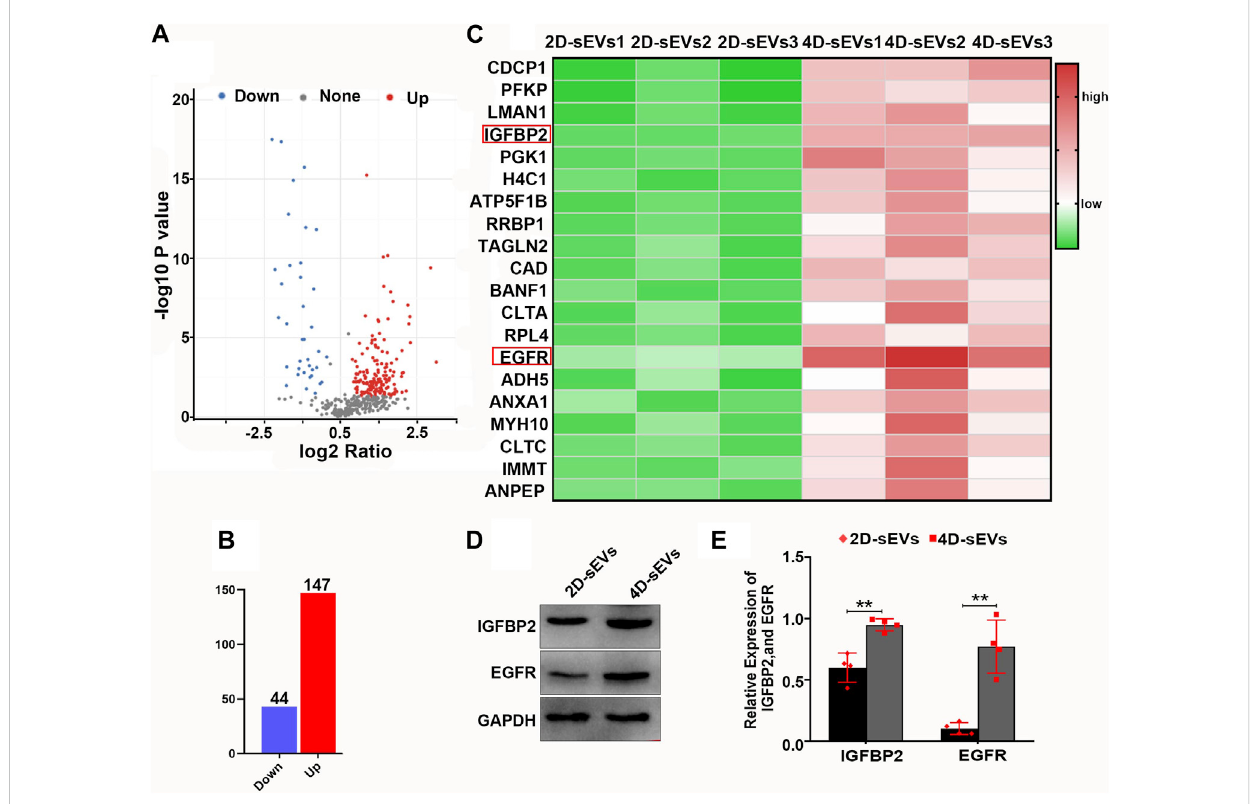
FIGURE 5 ProteomicanalysisofsEVsandcomparisonoftheresultsforboth2D-and4D-sEVs. (A,B) :Proteinchangesdetectedinthe2D-and4D-sEVsgroups are summarized on a volcano plot and histogram. (C) : Heat map showing the top 20 proteins with the most variation in the 2D- and 4D-sEVs groups. IGFBP2/EGFR is associated with M1 to M2 polarization of macrophages. (D) : The expressions of IGFBP2 and EGFR in two groups of sEVs were tested by western blotting. (E) : Quantitative analysis of Western blot. Statistic difference: ** p <